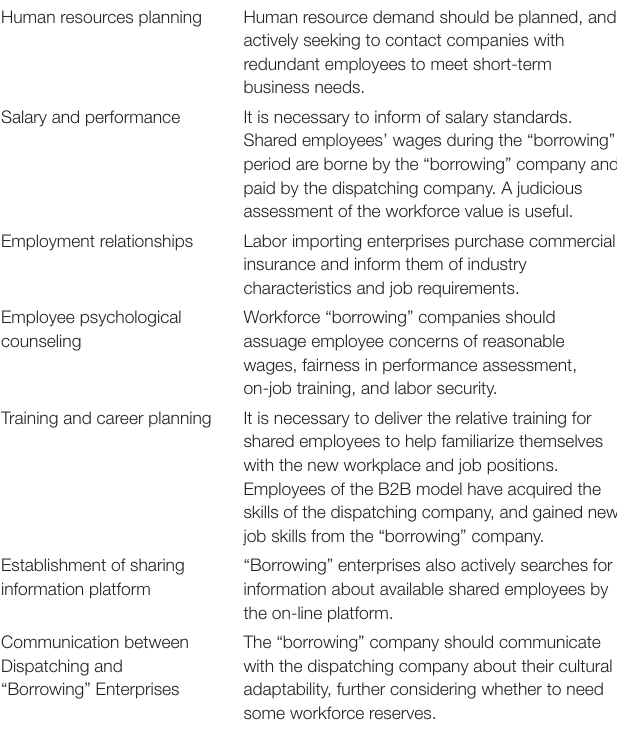
TABLE 2 | The description of demand-side